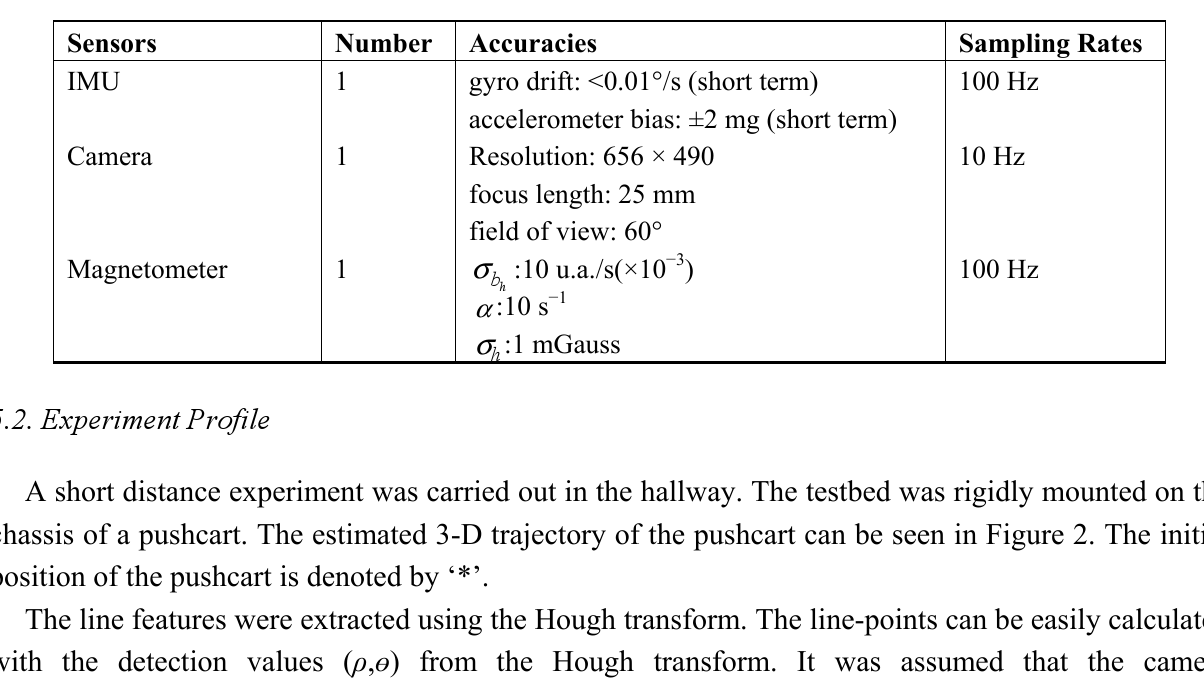
Table 1. Accuracies of the